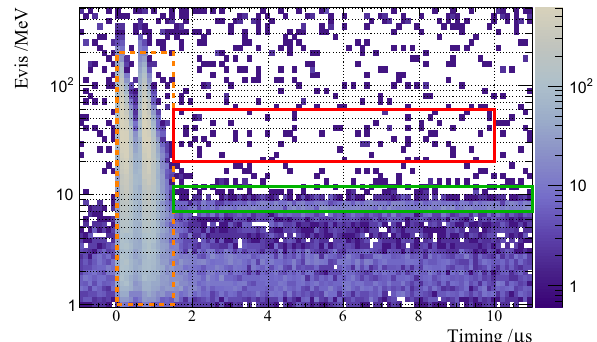
Fig. 1 A two-dimensional distribution of energy and timing before event selection, used to demonstrate the IBD selection region. The selected regions for the IBD prompt signal from positron (red box), the IBD delayed signal from gamma-rays resulted in thermal neutron capture on Gd (green box) and the beam on-bunch event (orange dashed box) are overlaid. Note that the events are shown around the prompt sig- nal timing region. There are two event clusters within 0–1.5 µ s, which reflect the proton beam structure of the MLF. They are caused by neu- trons produced at the mercury target. One can see that the IBD prompt signal region is well separated from the on-bunch region. The events in the IBD delayed signal region must also satisfy (cid:3) t p − d > 0 in the actual delayed coincidence